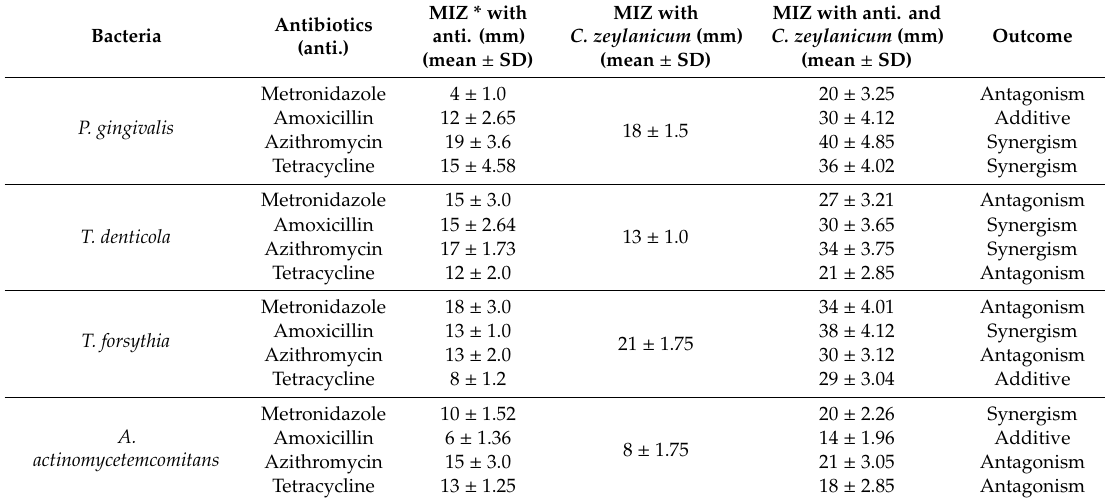
Table 3. Synergistic antimicrobial activity of C. zeylanicum with di ff erent antimicrobial agents.